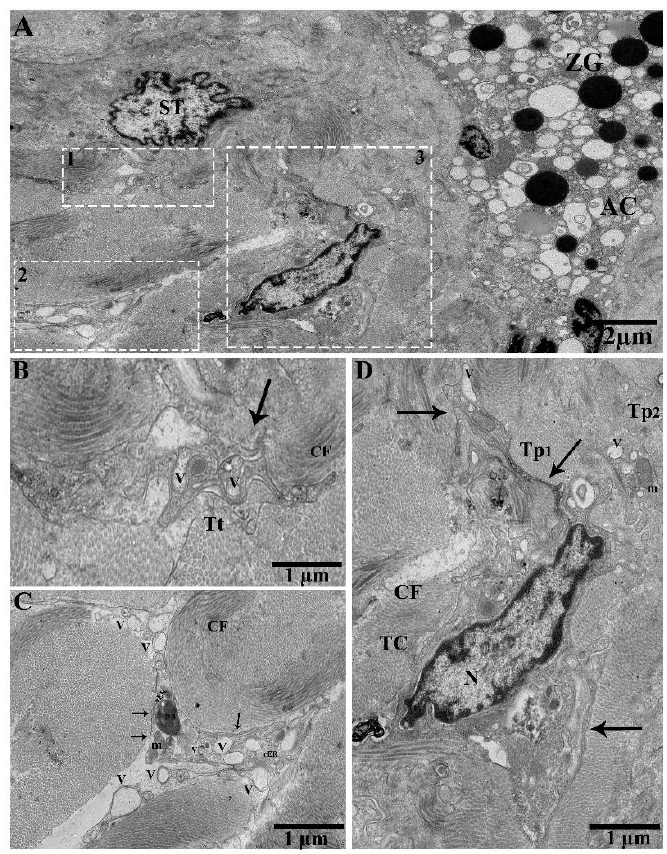
Figure 5. In between gland cells, small blood capillaries, and numerous shed / extracellular vesicles from the podoms in the connective tissue in the vicinity of collagen fibers. ( A ) TEM photograph in the pancreas showing the acinar cells, zymogen granules, and stellate cells. Square-marked areas 1, 2, and 3 in ( A ) are enlarged in ( B , C , D ), respectively. ( B ) Tortuous process and vesicles (black arrow). ( C ) Podoms containing numerous extracellular/shed vesicles, scattered in the vicinity of collagen fibers, and rough endoplasmic reticulum, mitochondria, and dense bodies are present. ( D ) A typical TC, which contains heterochromatin in their periphery, forming Tp 1 vesicles (arrows). Tp 2 contains mitochondria and vesicles in the podoms. N, nucleus; ZG, zymogen granules; AC, acinus; ST, stellate cell; Tt, tortuous process; V, vesicles; m, mitochondria; rER, rough endoplasmic reticulum; DB, dense body; CF, collagen fibers. Scale bar = 2 µm in ( A ); scale bar =1 µm in ( B – D ). Furthermore, TCs pinch o ff and shade vesicles from the cytoplasm. Coated pit releasing